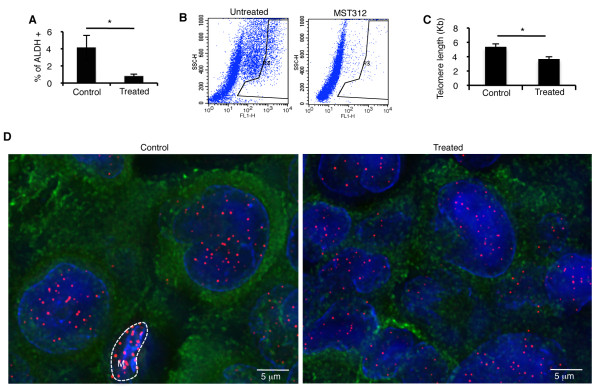
MST312 targets ALDH+ cells in vivo and reduces their telomere length. A and B: FACS analysis and quantification of dissociated tumors confirms, along with the immunhistochemical results, a decrease in ALDH+ cells in vivo after treatment with MST312. C: Quantification of telomeric length in ALDH+ cells present in tumors from treated and untreated mice. A significant reduction is found in mice administered with the antitelomeric therapy (p < 0.05). ALDH negative cells from the tumor bulk could not be accurately quantified due to massive necrosis. D: Representative FICTION image using probes for telomeres (red), immunofluorescence for ALDH (green), and nuclear staining (DAPI, in blue). Images show a lower intensity for telomeres in MST312-treated mice. The "M" labeled cell represents a murine fibroblast excluded from the analysis (small nuclei and longer telomeres).